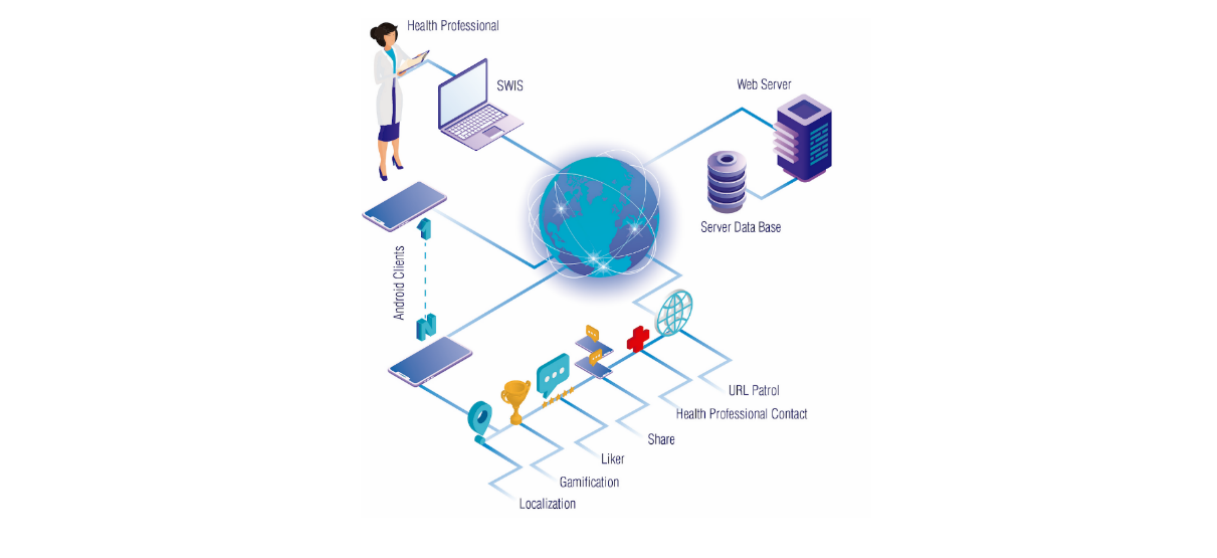
Figure 1. Architecture of solution and components of the UBESAFE system. This includes (1) simple web interface system, (2) web server, and (3) Android clients. SWIS: simple web interface system.